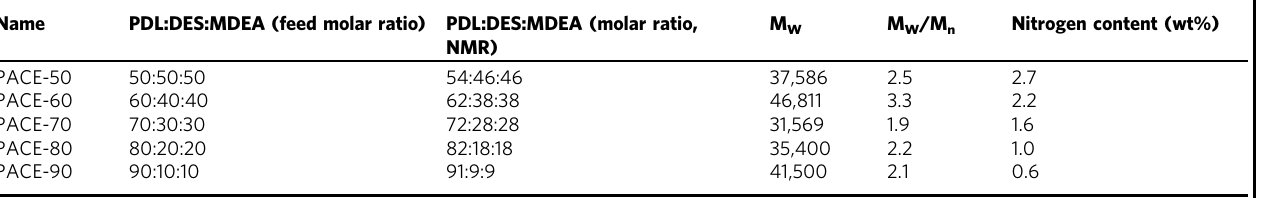
Table 1 Characterization of PACE polymers Name